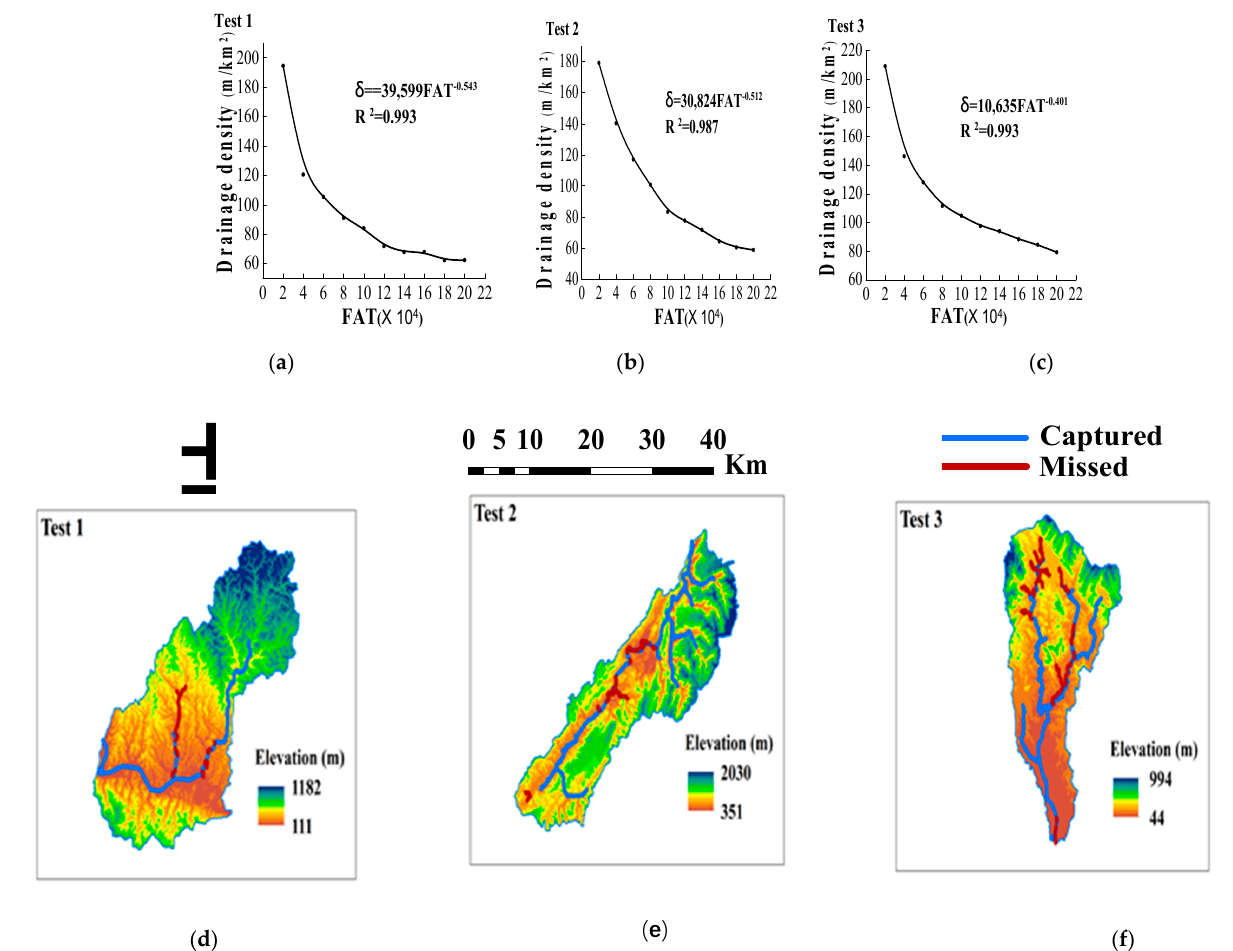
Figure 3. Maps of selected river networks in Hubei Province. ( a ) Scaling equation for test area 1. ( b ) Scaling equation for test area 2. ( c ) Scaling equation for test area 3. ( d ) Map of captured and missed streams in test area 1. ( e ) Map of captured Figure 4 the compass symbol is wrong displayed. and missed streams in test area 2. ( f ) Map of captured and missed streams in test area 3.